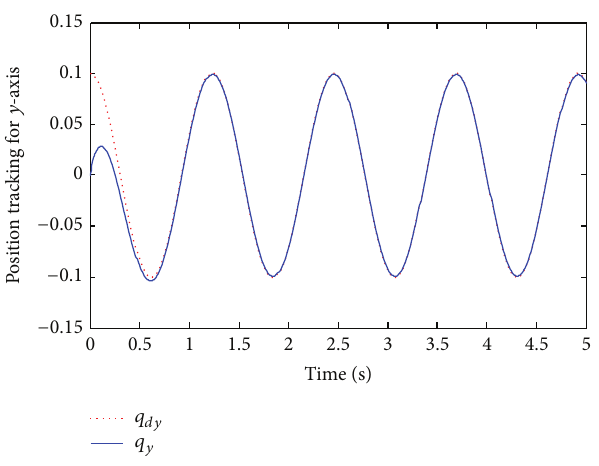
Figure 5: Position tracking of 𝑦 -axis with adaptive neural sliding